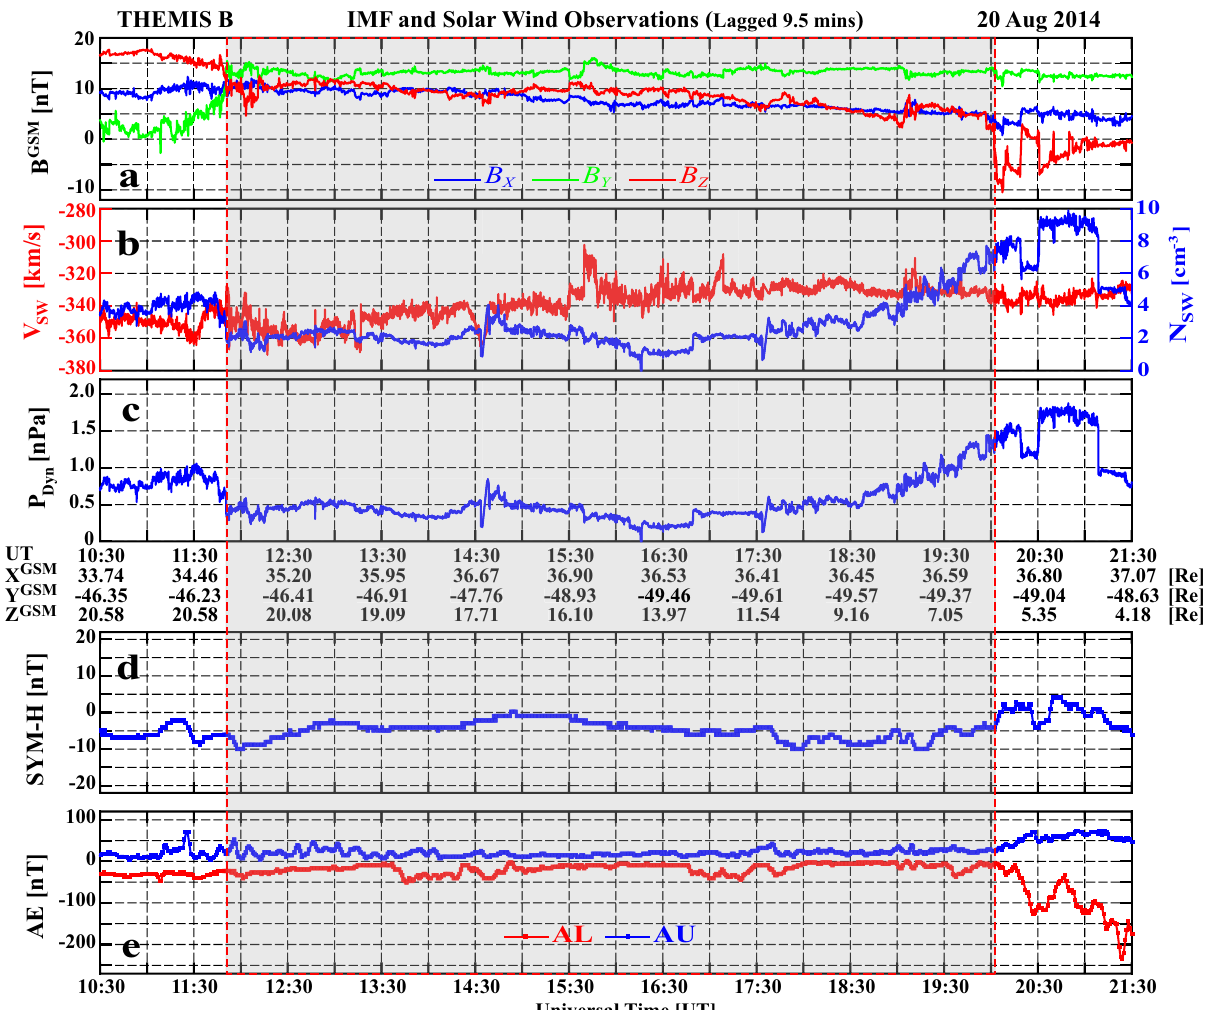
Fig. 1 An overview of the interplanetary conditions and geomagnetic indices on 20th August 2014. a The IMF components in geocentric solar magnetosphere (GSM) coordinates; b the solar wind number density and speed; c the solar wind dynamic pressure, P Dyn ; d the provisional SYM-H geomagnetic index (from 6 stations); and e the provisional auroral electrojet geomagnetic indices (from 11 stations): red and blue lines are for AU and AL. Interplanetary data is measured by the Time History of Events and Macroscale Interactions during Substorms (THEMIS) 44 B satellite (in the moon orbit), and has been lagged by 9.5 min to the dayside